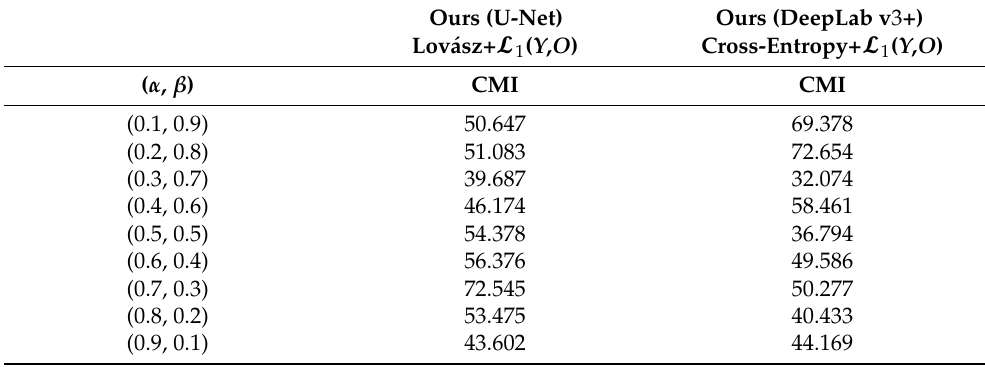
Table 5. Ablation study for α and β .